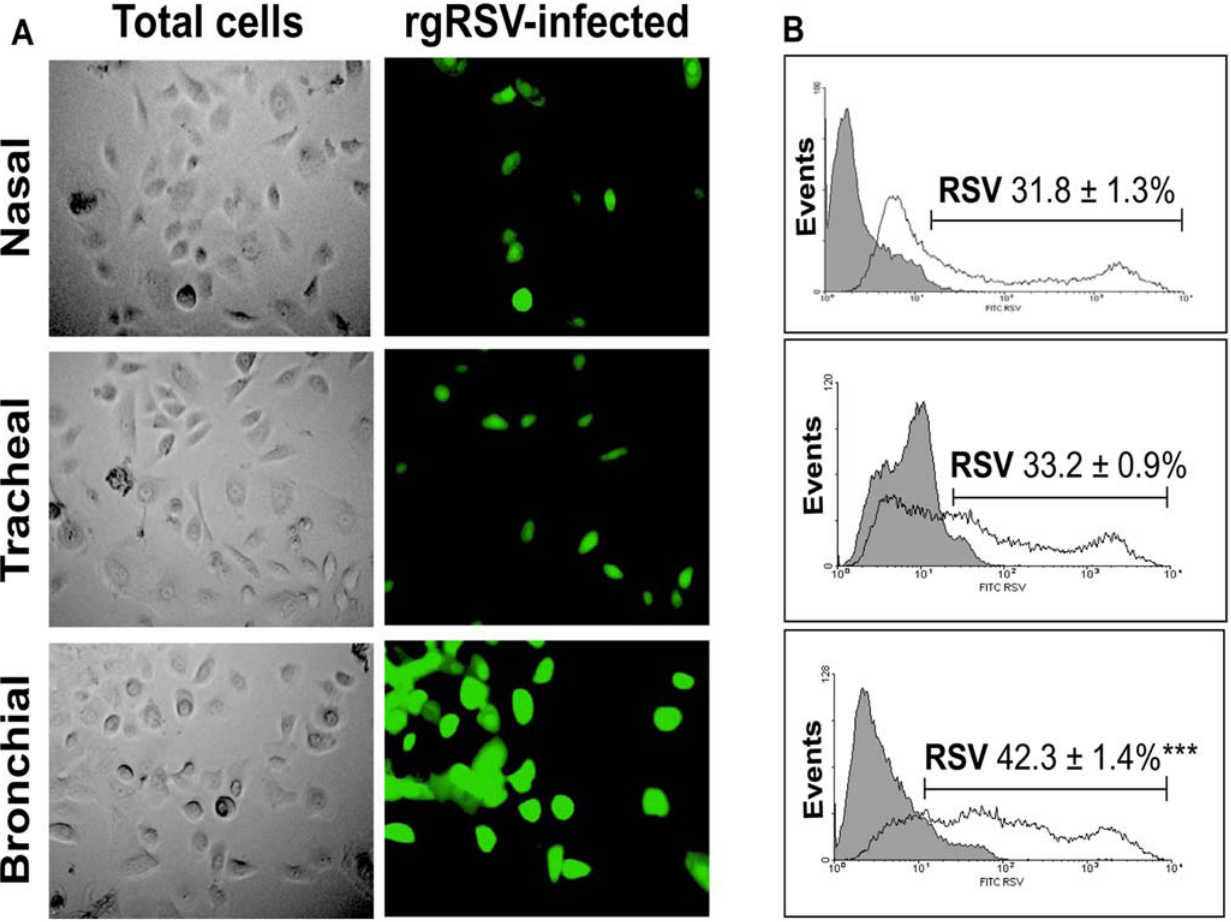
Figure 1. RSV infects bronchial epithelial cells more efficiently. (A) Human nasal, tracheal, and bronchial epithelial cells after infection with GFP-expressing RSV (rgRSV) at 1 MOI for 48 h. The bright field panels (left) show the total number of cells. The green fluorescent cells (center) represent those which are actively infected with RSV. (B) Bronchial epithelial cells are the most susceptible to RSV infection. Flow cytometric data show the percentage of fluorescent (infected) cells in each panel compared to the non-infected control cells (shaded histogram). Data are expressed as the mean 6 SEM (n=4 experiments). ***= p , 0.001 compared to nasal or tracheal cells.